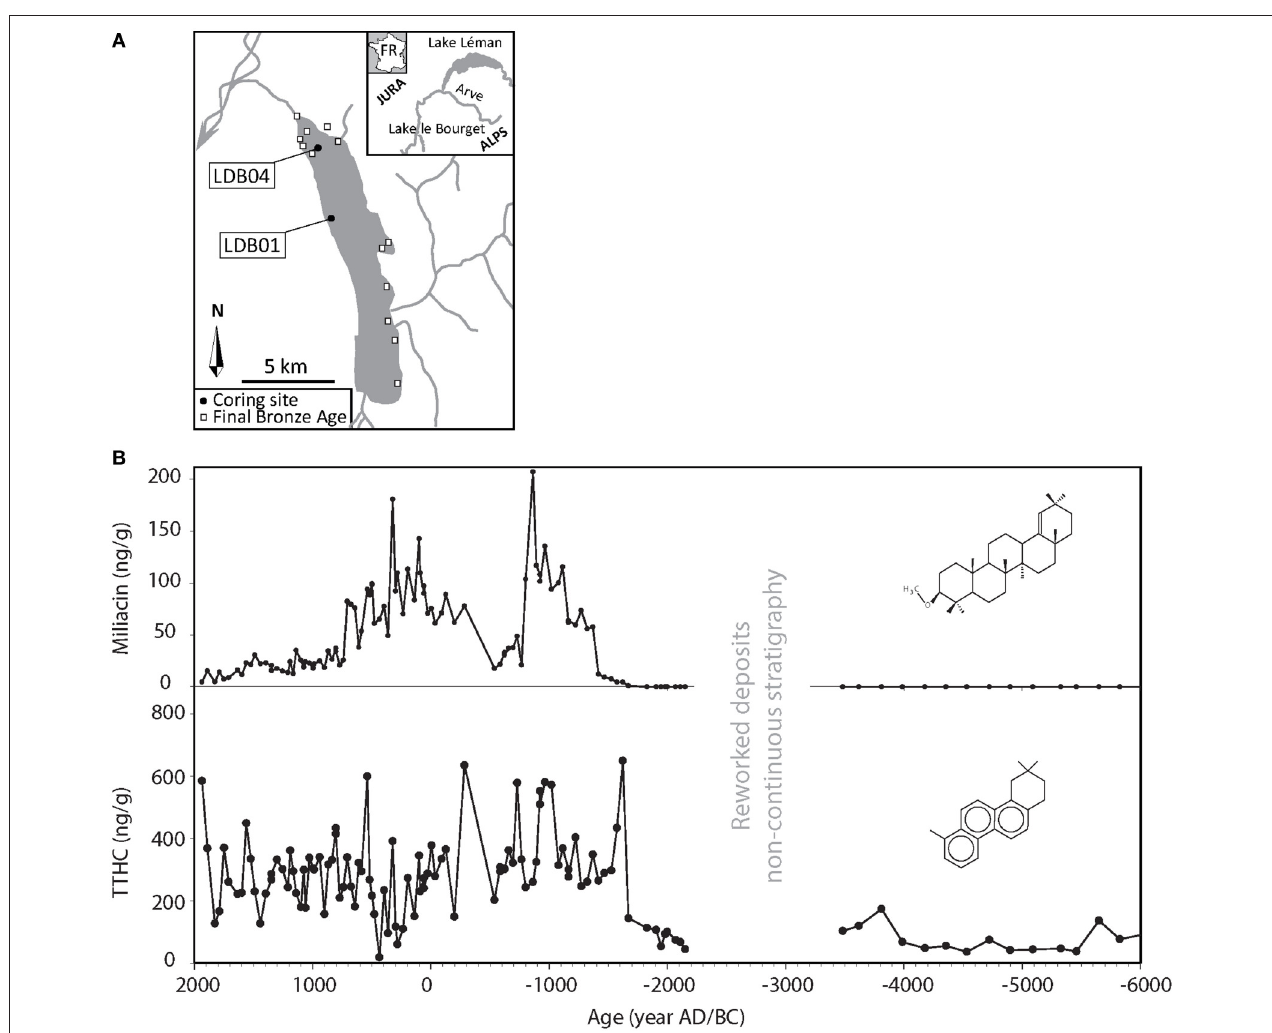
FIGURE 1 | (A) Location of Lake le Bourget with coring sites and of Bronze Age archaeological sites. (B) Evolution of miliacin and TTHC concentrations (with structures) in core LDB04. Modified from Jacob et al.